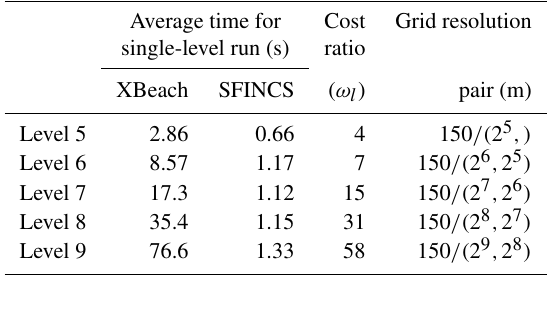
Table 3. Summary of average time taken to run SFINCS and XBeach at each level for the Carrier–Greenspan test case. As can be seen from Eqs. (B4) and (3), at every level (apart from the coarsest level) a pair of simulations at two different resolutions is required. These resolutions are shown in the “grid resolution pair” column, and we recall that the same resolutions are used in each model.